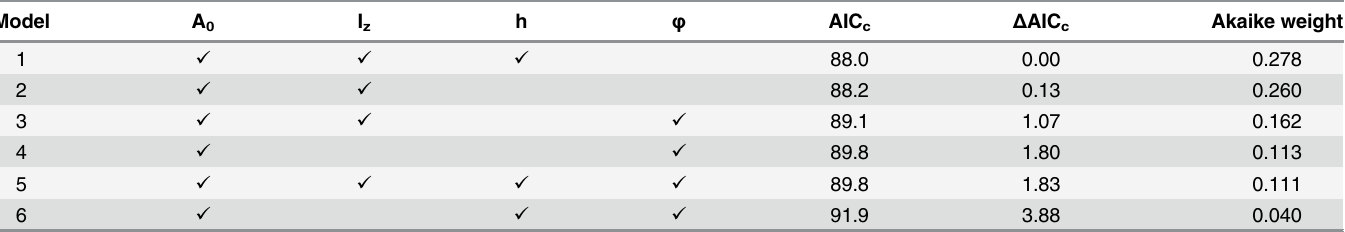
Table 2. Summary output from the multi-model inference approach. The relative contributions of surface area (A 0 ), the percent transmission per metre (I z ), altitude above sea level (h), and latitude ( φ ) are shown. Confidence set of models ranked according to their adjusted Akaike Information Criterion (AICc) statistic. Model